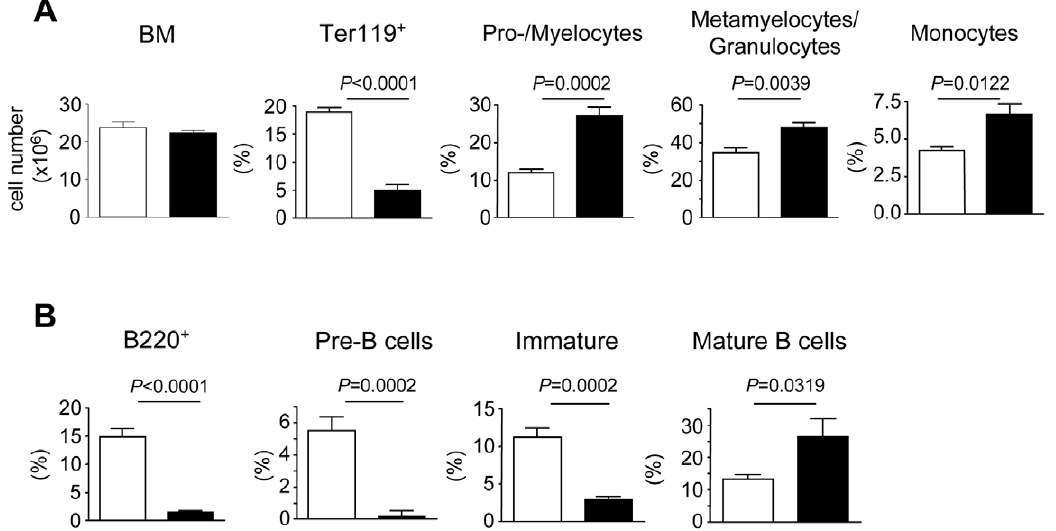
Figure 3. Erythroid, myeloid and B cell subsets in BM from IBD. (A) Bone marrow cellularity, percentages of Ter119 + cells and myelocytes subsets by CD11b and Gr-1 expression (see fig. 1 legend) in BM of mice with IBD, n=5. (B) Statistical analysis of B cell subsets representation in BM of mice with IBD, n=5. White bars: healthy; black bars: IBD. Mice were analysed 4 weeks after transfer of CD4 + cells.